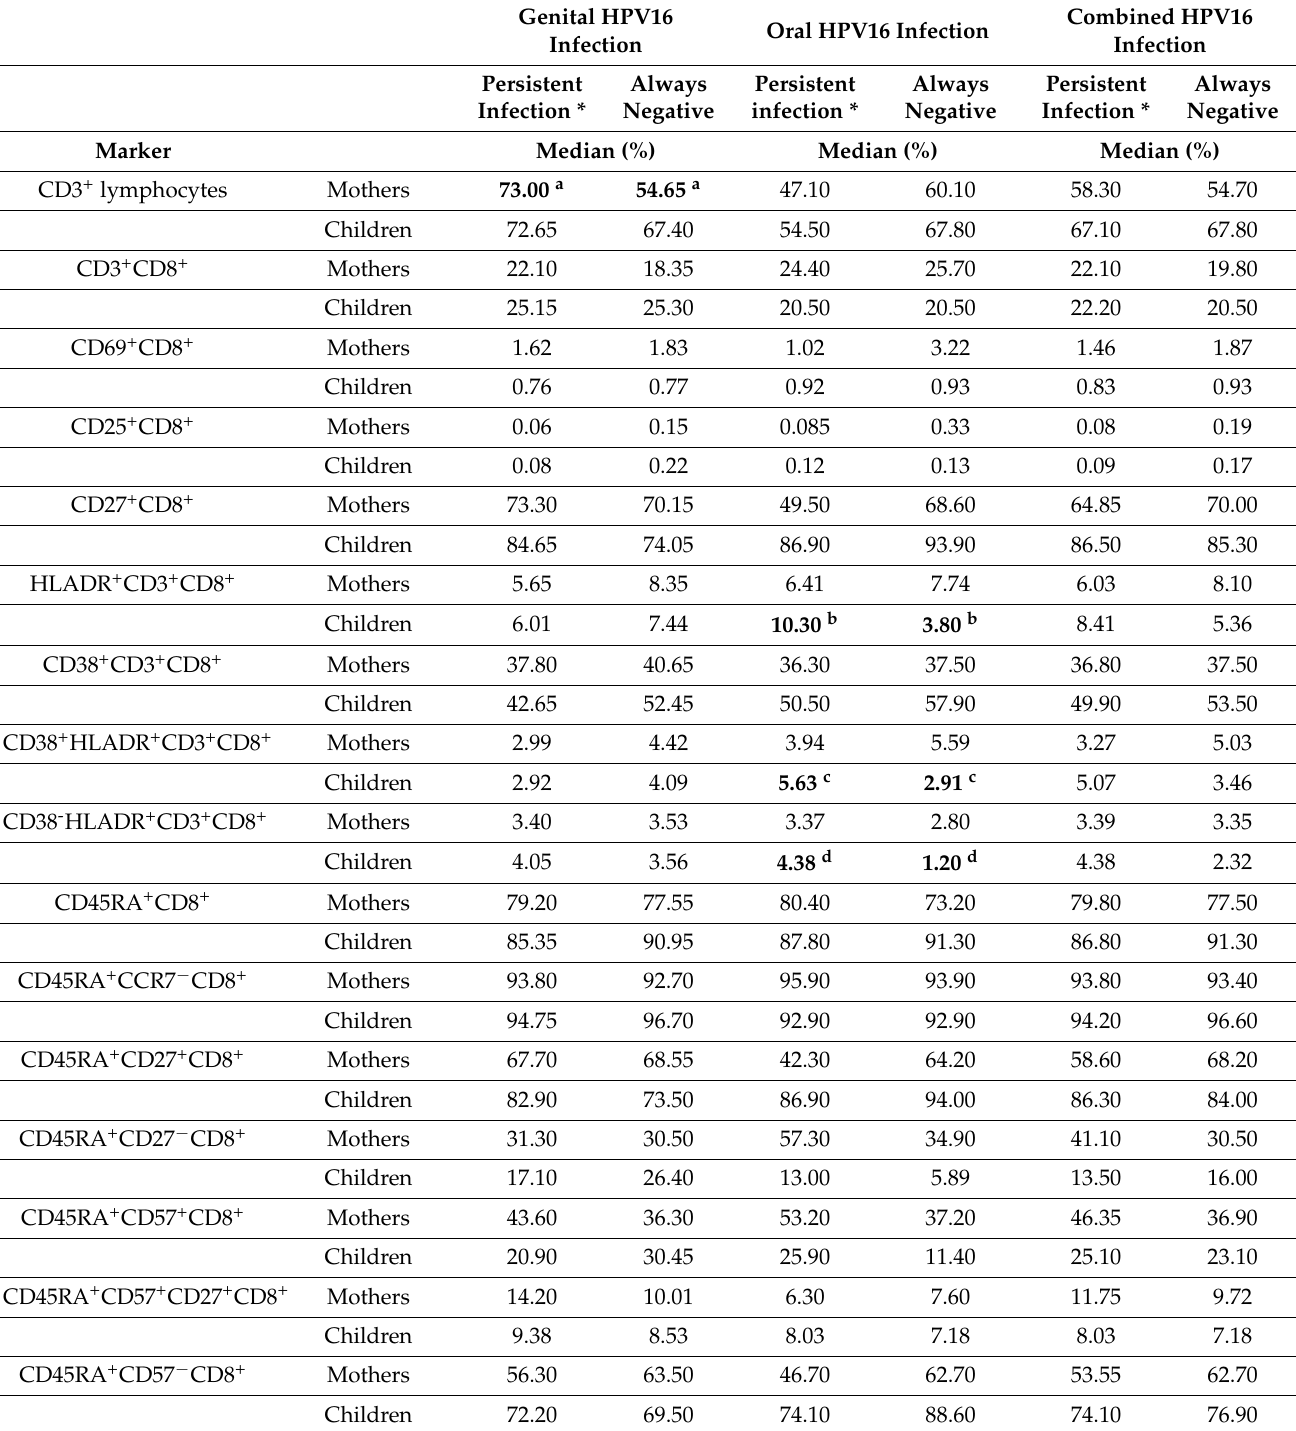
Table 4. CD8 + T-cell immunophenotypic subset distribution of the mother–child pairs stratified according to mother’s genital and oral HPV status. Significant median comparisons between the subgroups are